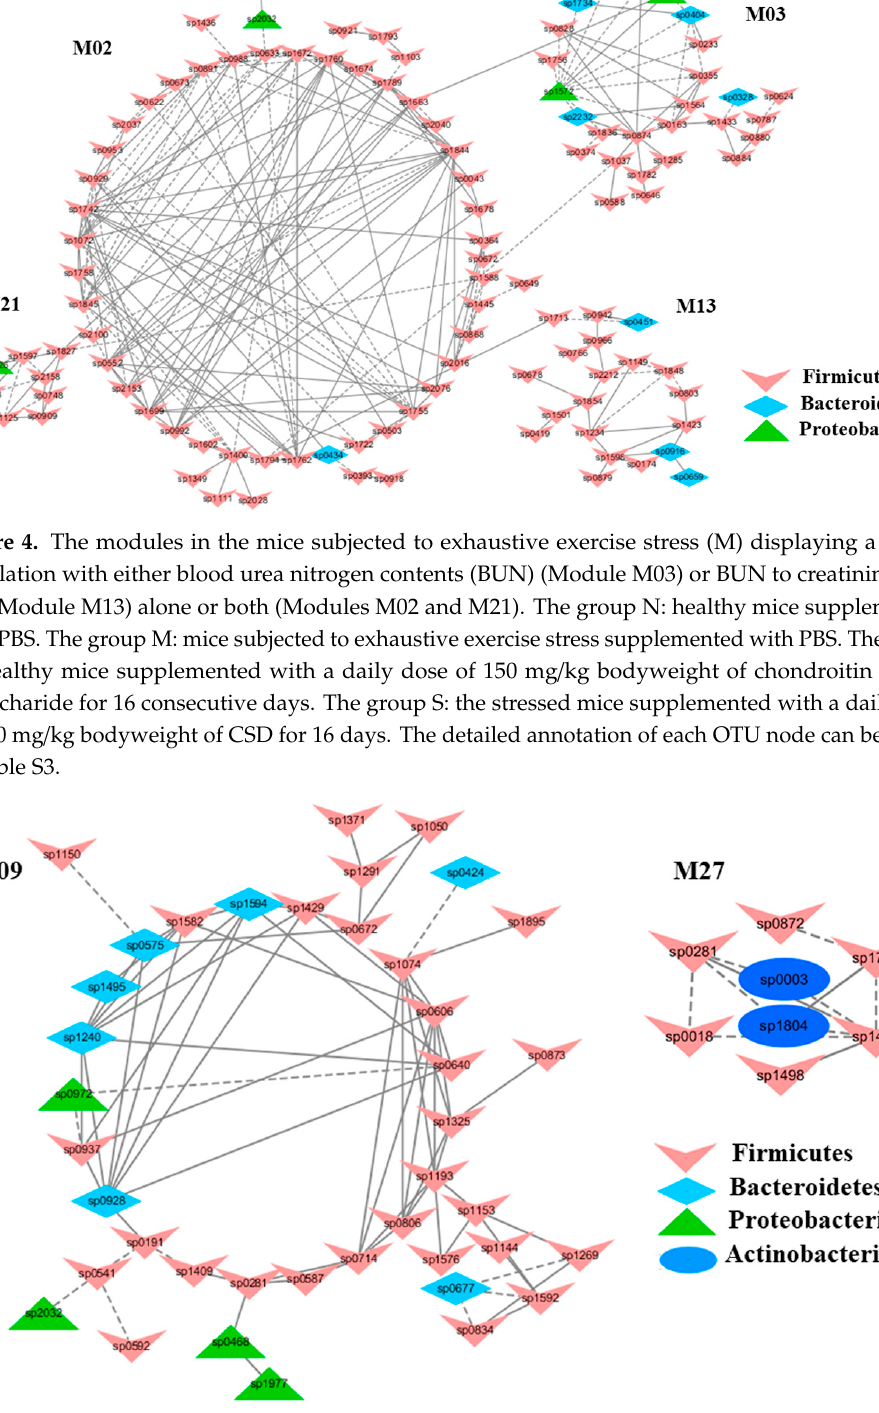
Figure 5. The modules with a strong correlation with kidney malondialdehyde concentrations (MDA), a lipid peroxidation marker. The interactions among different nodes (OTUs) within a module were shown: solid line: positive correlation; dashed line: negative correlation. The color of each node (OTU) indicated the phylum this OTU was assigned. Modules M27 and N09 were identified from the groups M and N, respectively. The group N: healthy mice supplemented with PBS; The group M: mice subjected to exhaustive exercise stress supplemented with PBS. The detailed annotation of each OTU node can be found in Table